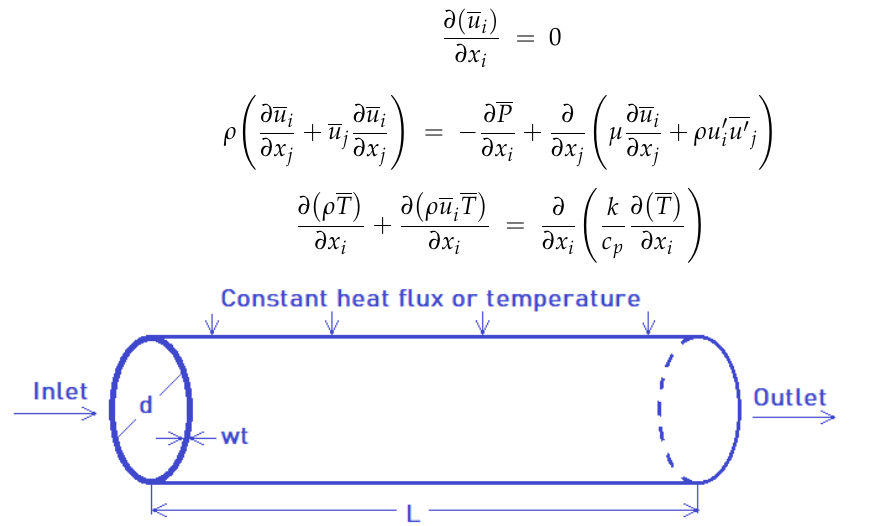
Figure 4. Scheme of the model.